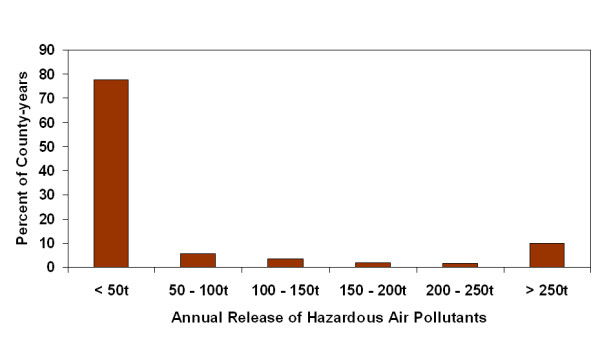
Frequency distribution of county-year release of hazardous air pollutants.